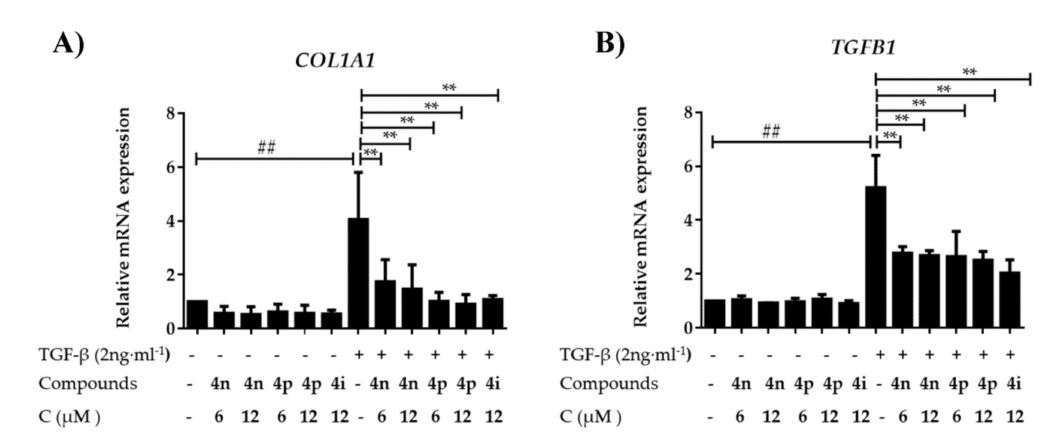
Figure 2. E ff ects of key compounds ( 4i , 4n and 4p ) inhibiting COL1A1 ( A ) and TGFB1 ( B ) and on mRNA level in LX-2 cells after a 24 h treatment. Data were analyzed by Real-time PCR, and presented as the mean ± SEM, p < 0.05, (##) p < 0.01 as compared to that of control group; p < 0.05, (**) p < 0.01 as compared to that of TGF- β 1 group. The mRNA expression levels were normalized against GAPDH. The mRNA expression levels were normalized against GAPDH. The experiment was repeated three